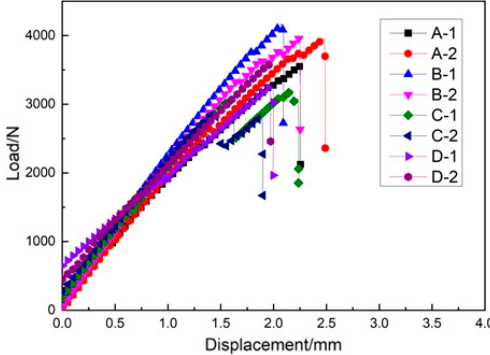
Figure 17. Weft tensile load–displacement curve.